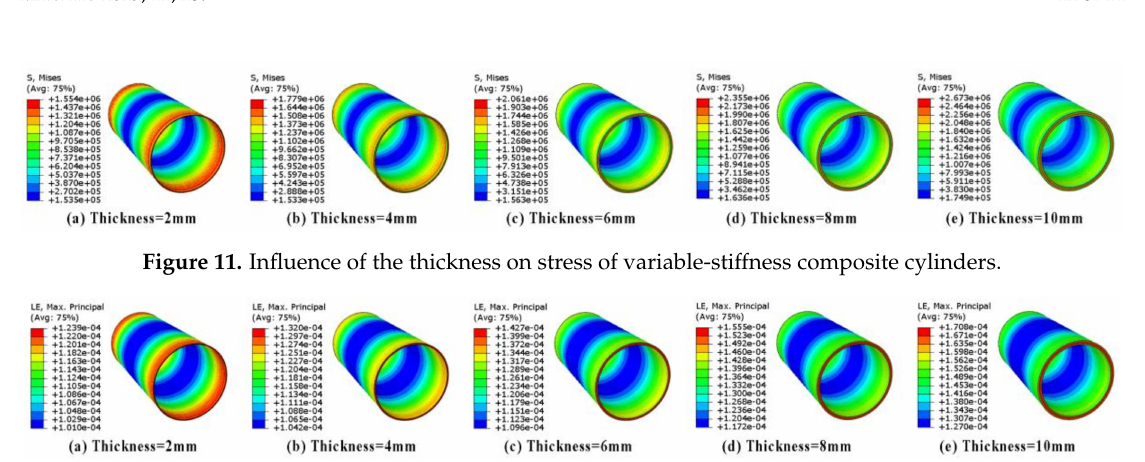
Figure 12. Influence of the thickness on deformation of variable-stiffness composite